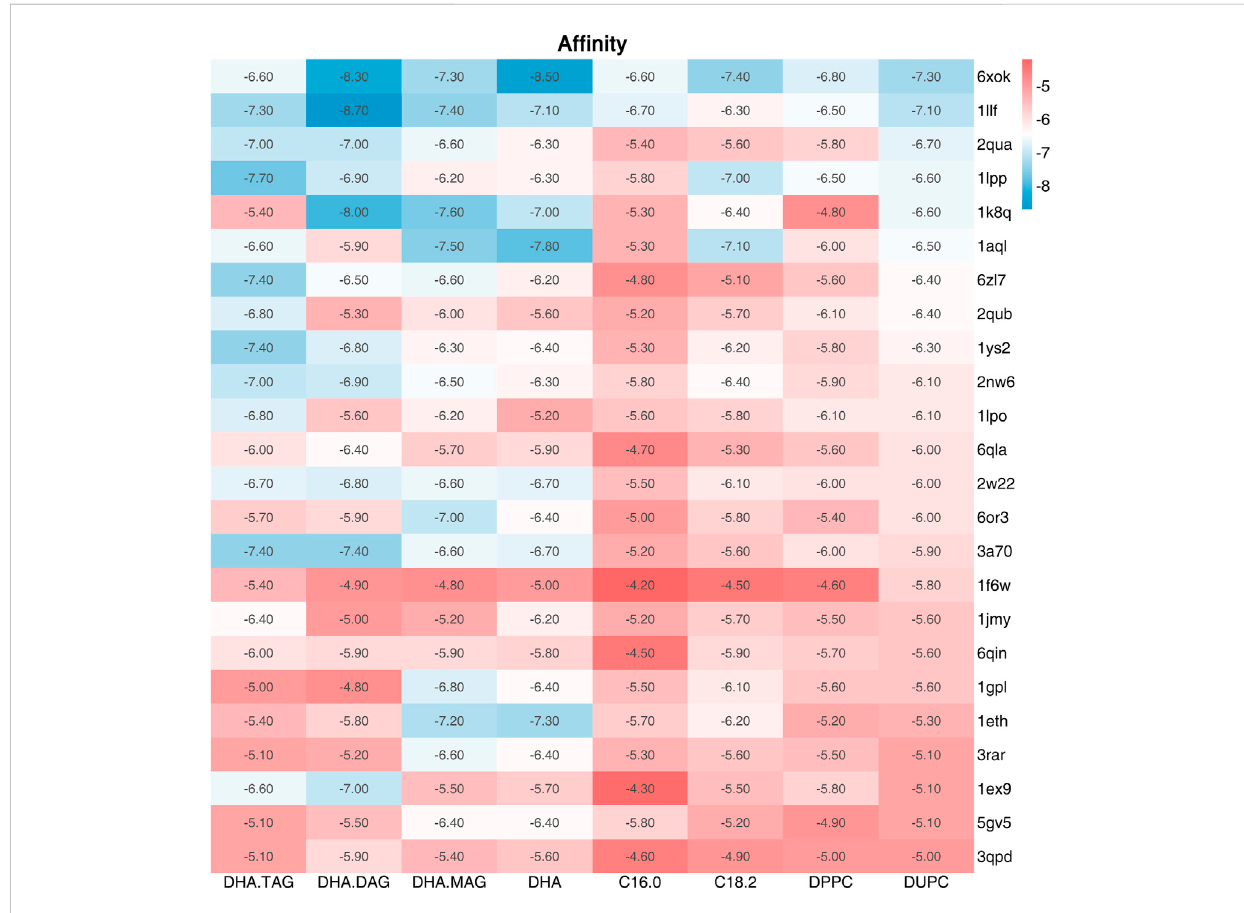
FIGURE 1 Af fi nity (kcal/mol) between the ligand and the screened lipases (Af fi nity ≤ − 5.0 kcal/mol and Distance ≤ 4.5